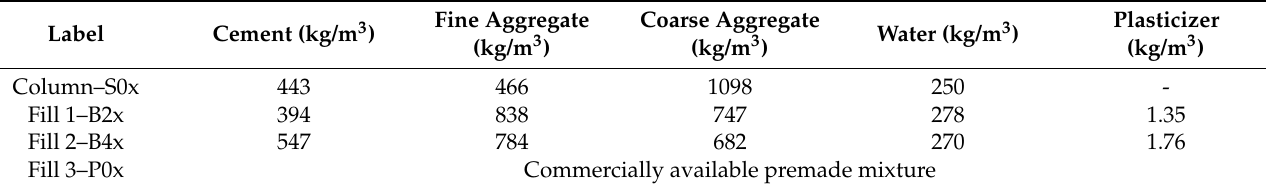
Table 3. Properties of concrete—mean values.